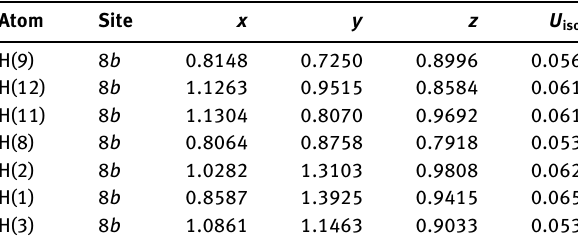
Table 2: Fractional atomic coordinates and isotropic or equivalent isotropic displacement parameters (Å 2